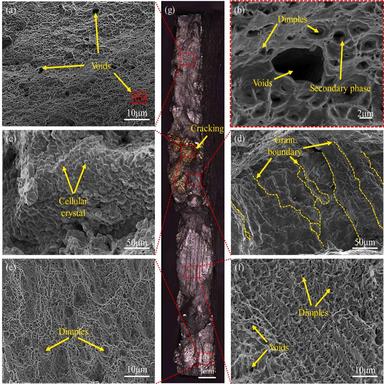
Fracture morphology of the tensile sample in the torch-travelling direction for the FGM. (a) Typical morphology, with large and deep dimples and voids, (b) high magnetization of the box area with dash line in a, (c-d) fracture appearances near the crack, (e-f) secondary phases of small spherical particles in the dimples, (g) overall macrostructure of the fracture.